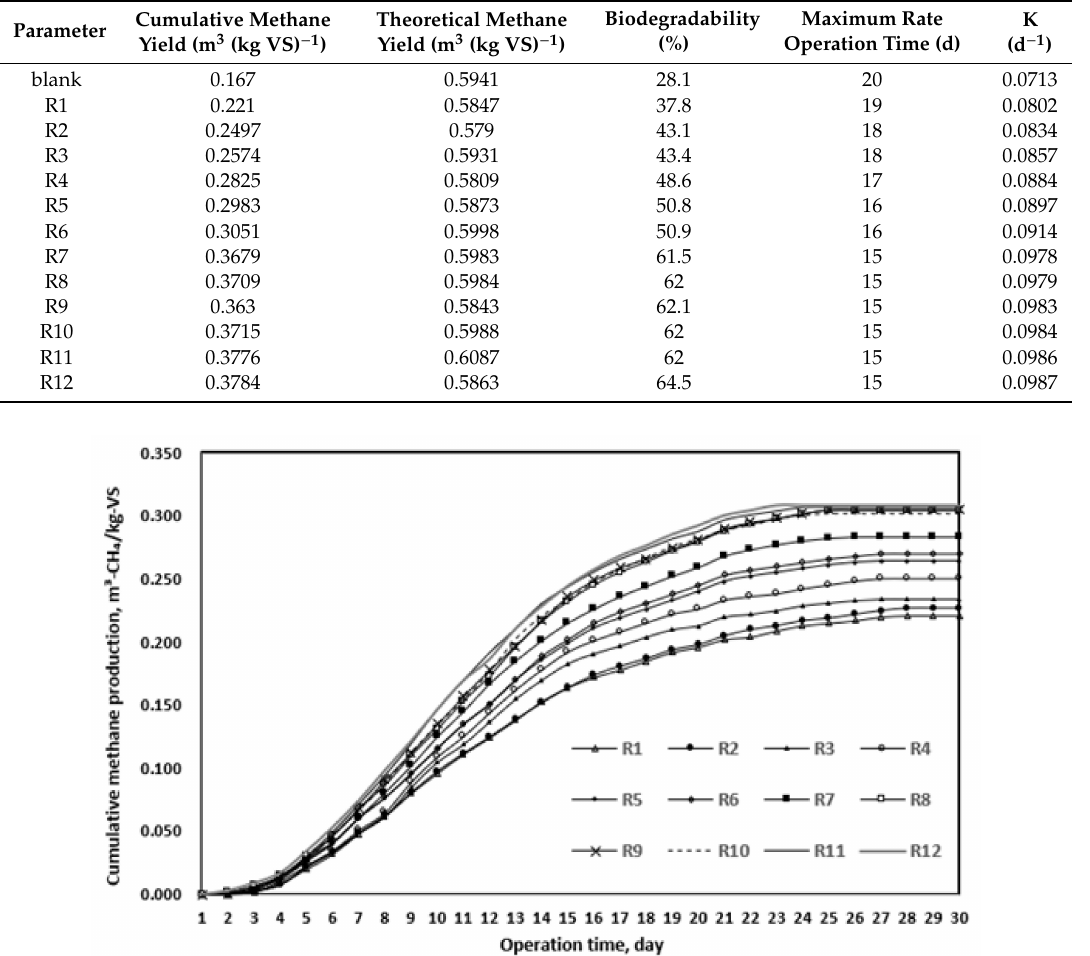
Table 9. BMP test results upon thermal hydrolysis.